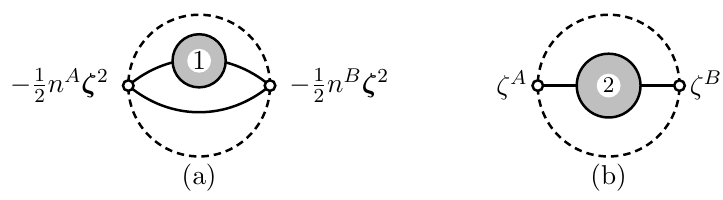
log 3 term in the 2-point correlator. In (a) the blob p ( (cid:21) ) 3